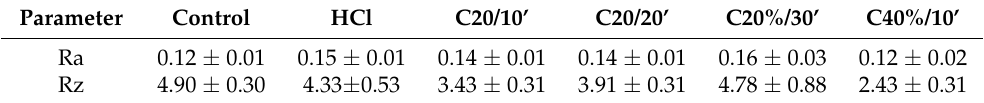
Table 2. Roughness parameters values of the titanium treated